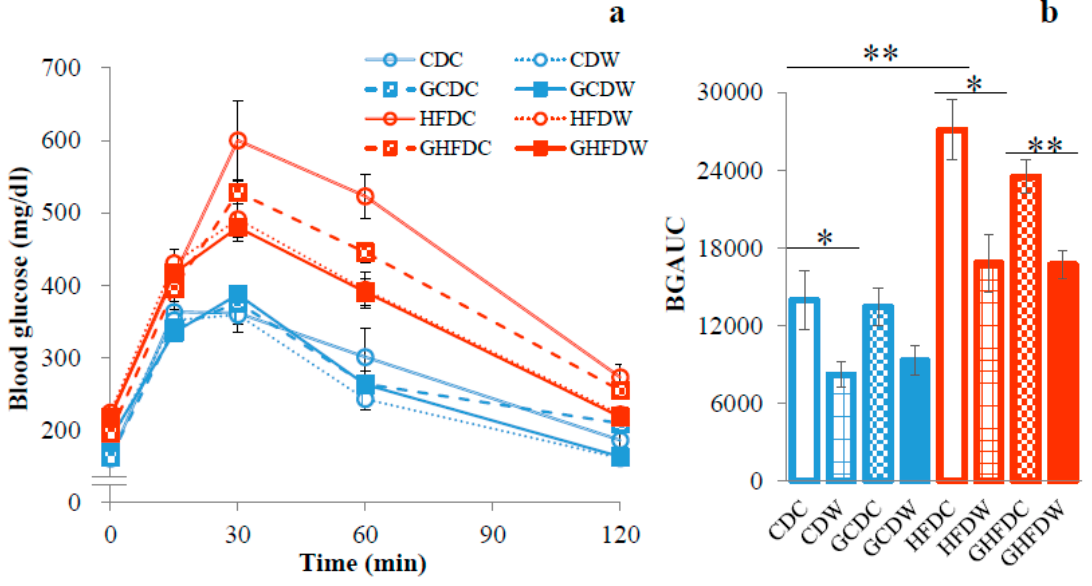
Figure 2. The supplemental e ff ect of wheel running on blood glucose concentration and the incremental area under the curve (AUC) of blood glucose during GTT in PHGG intake mice under CD and HFD feeding. Time-dependent blood glucose level after glucose load (2 g / kg body mass) into the abdominal cavity ( a ) and the corresponding incremental blood glucose area under the curves (BGAUC) ( b ). The values were expressed as the mean ± S.E.M. * p < 0.05 and ** p < 0.01.